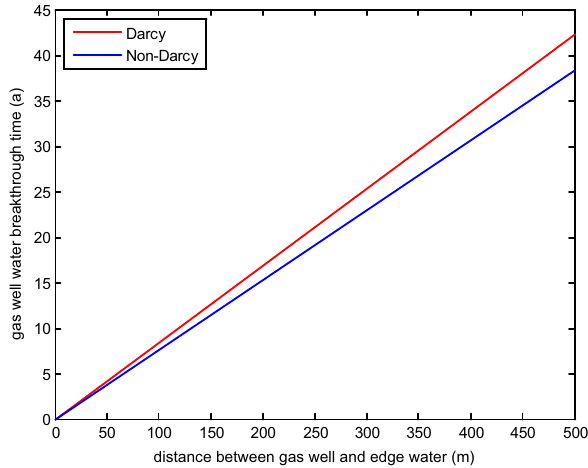
Fig. 4 The effect of flow state on water breakthrough